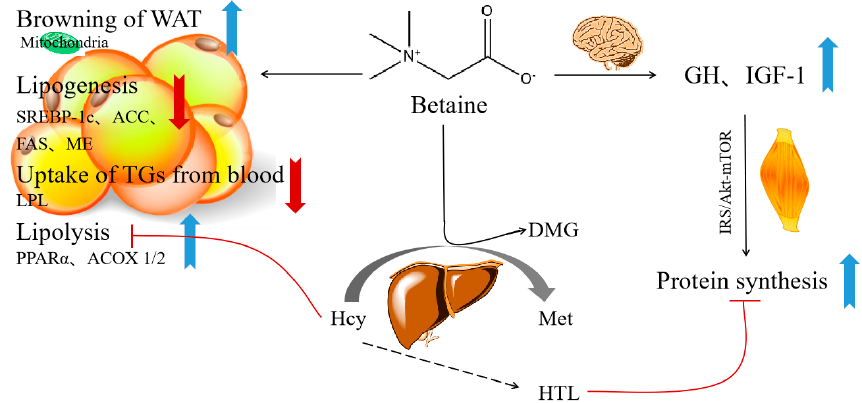
Figure 6. Potential mechanisms of how dietary betaine prevents obesity. PPAR α , peroxisome proliferator-activated receptor α ; ACOX 1/2, acyl-CoA oxidase 1/2; SREBP-1c, element-binding protein-1c; ACC, acetyl-CoA carboxylase; FAS, fatty acid synthase; ME, malic enzyme; LPL, lipoprotein lipase; WAT, white adipose tissue; Hcy, homocysteine; DMG, dimethylglycine; Met, methionine; GH, growth hormone; IGF-1, insulin-like growth factor 1; HTL, homocysteine thiolactone.